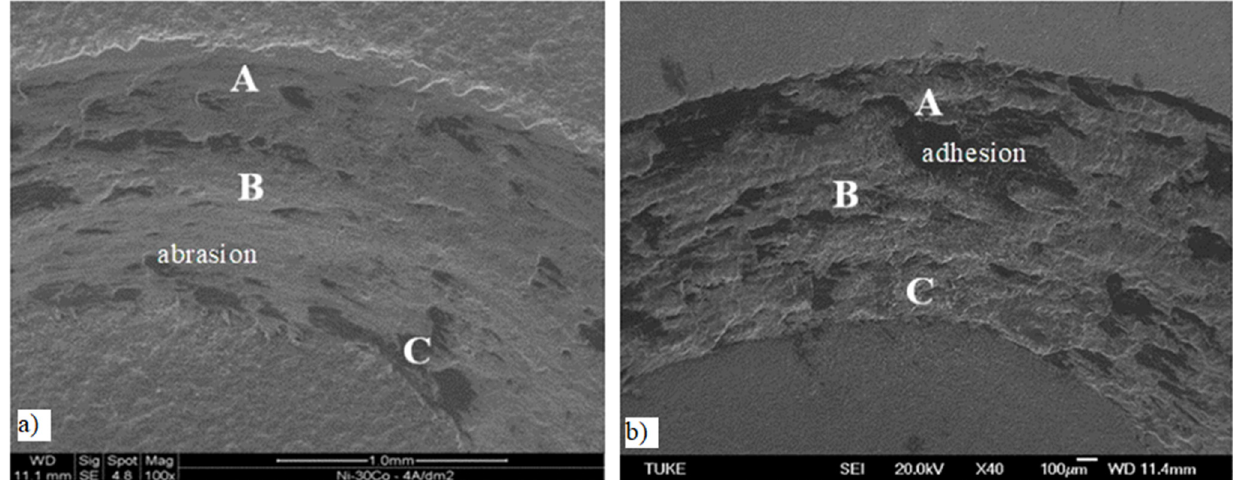
Figure 11. The worn surface of Ni-Co coatings: ( a ) Sample 1; ( b ) Sample 2. The A, B, and C places mark the EDX analysis locations.